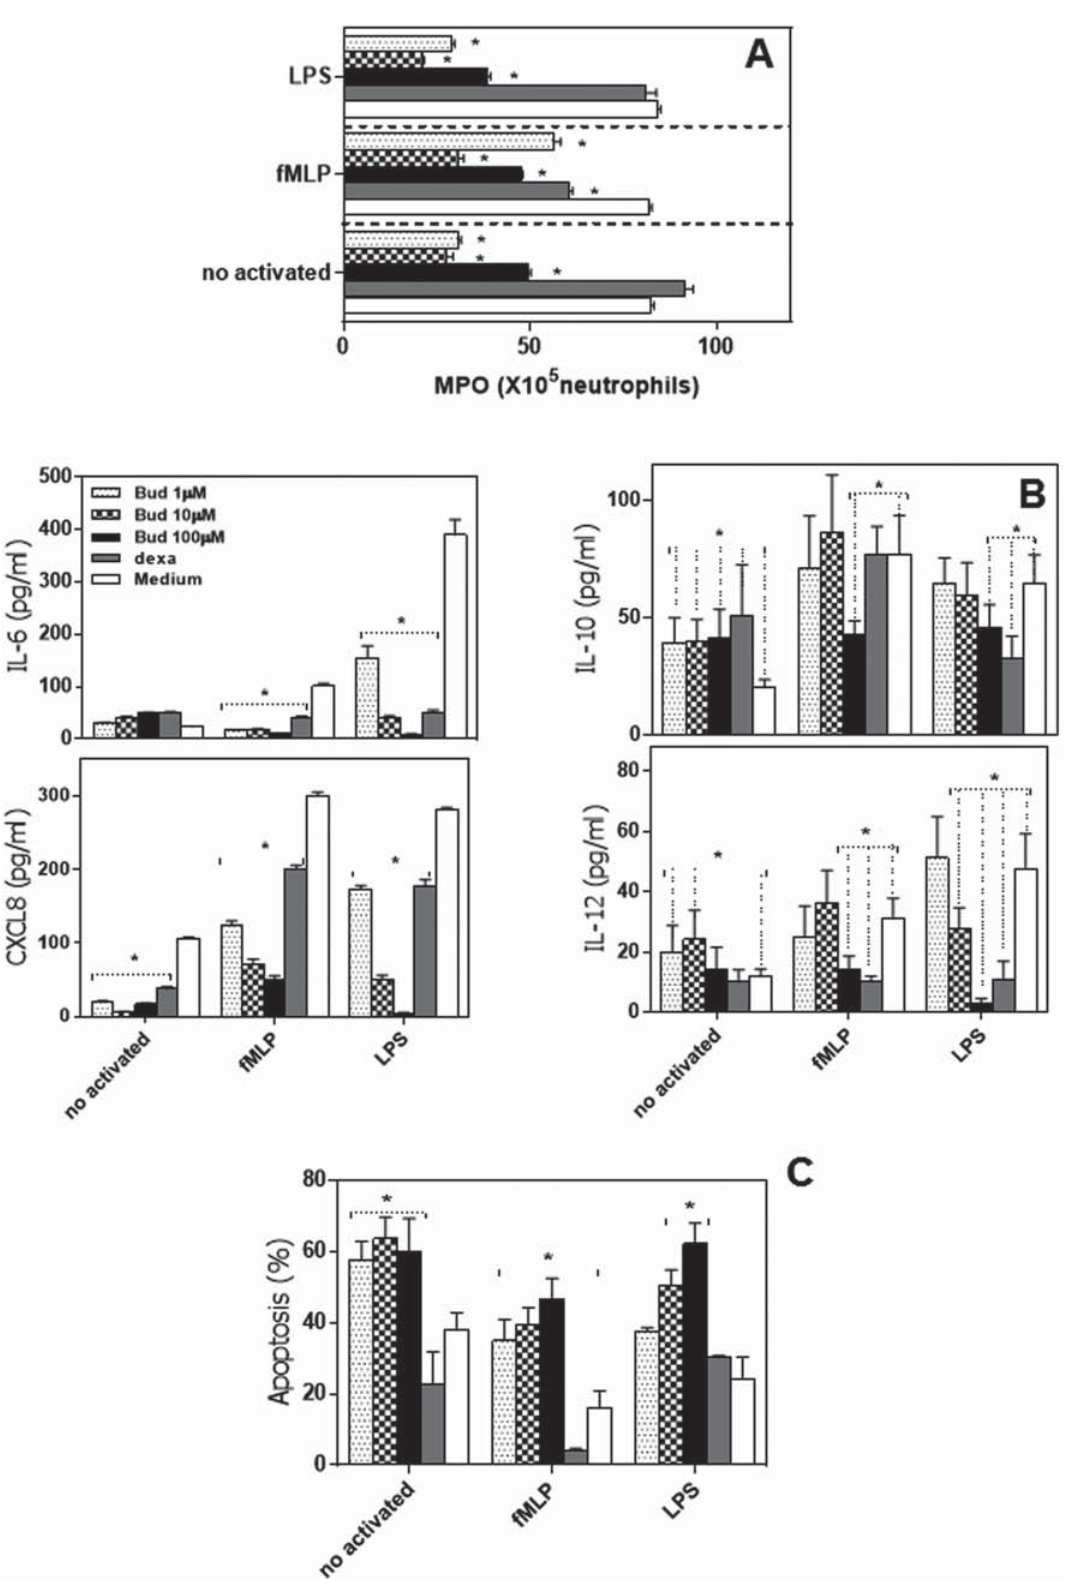
Figure 1- Budlein A negatively regulated the neutrophil activation to fMLP and LPS. Neutrophils from healthy controls were (cid:70)(cid:88)(cid:79)(cid:87)(cid:88)(cid:85)(cid:72)(cid:71)(cid:3)(cid:90)(cid:76)(cid:87)(cid:75)(cid:3)(cid:80)(cid:72)(cid:71)(cid:76)(cid:88)(cid:80)(cid:3)(cid:82)(cid:81)(cid:79)(cid:92)(cid:3)(cid:82)(cid:85)(cid:3)(cid:69)(cid:88)(cid:71)(cid:79)(cid:72)(cid:76)(cid:81)(cid:3)(cid:36)(cid:3)(cid:11)(cid:20)(cid:3)(cid:541)(cid:48)(cid:15)(cid:3)(cid:20)(cid:19)(cid:3)(cid:541)(cid:48)(cid:15)(cid:3)(cid:82)(cid:85)(cid:3)(cid:20)(cid:19)(cid:19)(cid:3)(cid:541)(cid:48)(cid:12)(cid:15)(cid:3)(cid:71)(cid:72)(cid:91)(cid:68)(cid:80)(cid:72)(cid:87)(cid:75)(cid:68)(cid:86)(cid:82)(cid:81)(cid:72)(cid:3)(cid:11)(cid:20)(cid:19)(cid:19)(cid:541)(cid:48)(cid:12)(cid:15)(cid:3)(cid:69)(cid:88)(cid:71)(cid:79)(cid:72)(cid:76)(cid:81)(cid:3)(cid:83)(cid:79)(cid:88)(cid:86)(cid:3)(cid:73)(cid:48)(cid:47)(cid:51)(cid:15)(cid:3)(cid:82)(cid:85)(cid:3)(cid:69)(cid:88)(cid:71)(cid:79)(cid:72)(cid:76)(cid:81)(cid:3) plus LPS. (A) Analysis of myeloperoxidase activity (MPO). B) IL-6, CXCL8, IL-10, and IL-12 production were analyzed by ELISA. (C) Flow cytometric analysis of apoptosis. The bars represent the mean±SEM for each volunteer individually (cid:87)(cid:72)(cid:86)(cid:87)(cid:72)(cid:71)(cid:17)(cid:3)(cid:13)(cid:3)(cid:83)(cid:31)(cid:19)(cid:17)(cid:19)(cid:24)